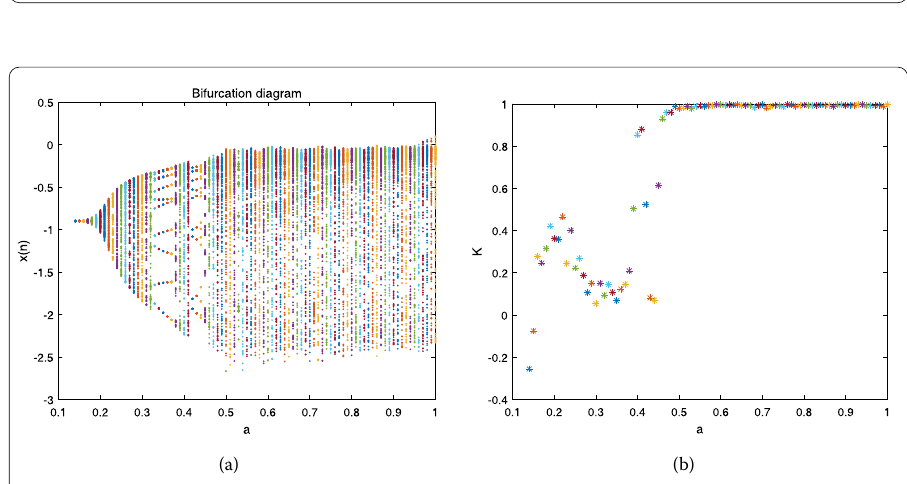
Figure 3 Bifurcation diagram and K median value. The bifurcation diagram ( a ) and K median value ( b ) of system (10) with b = 0.9, v = 0.9 versus parameter a